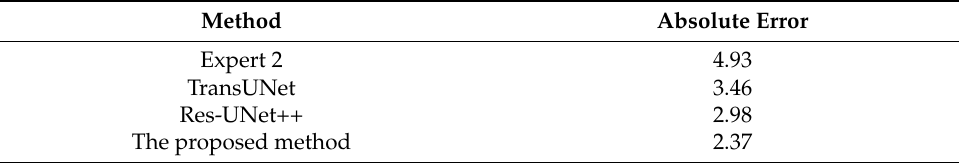
Table 3. Absolute mean error of the number of macular edema regions.